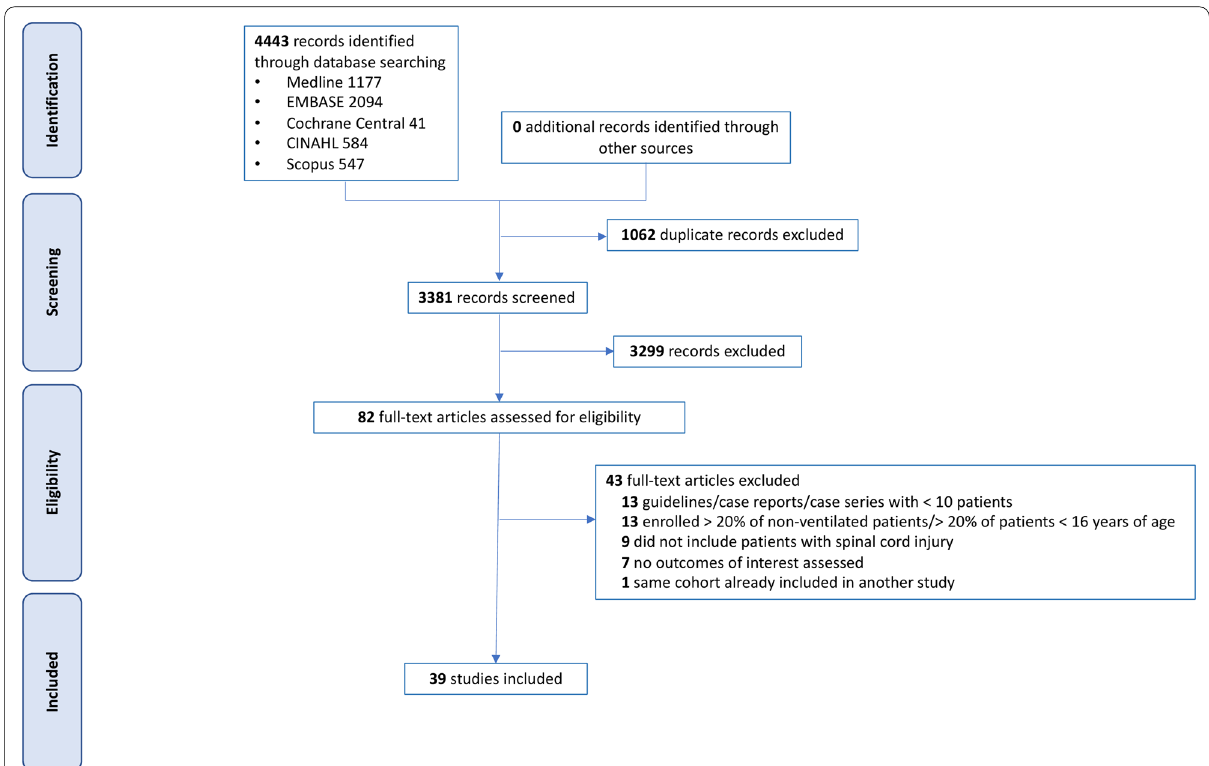
Fig. 1 Flowchart of the study selection process according to PRISMA (www. prisma- state ment.